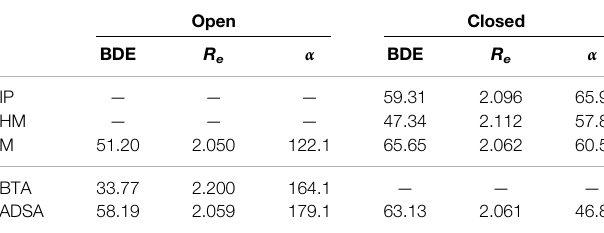
TABLE1| Bonddissociationenergy(BDE),inkcal/mol,S-Sbondlength( R e ),inÅ, and R-SS-R dihedral angle ( α ), in degrees, for the open and closed conformations of the one-chain molecular